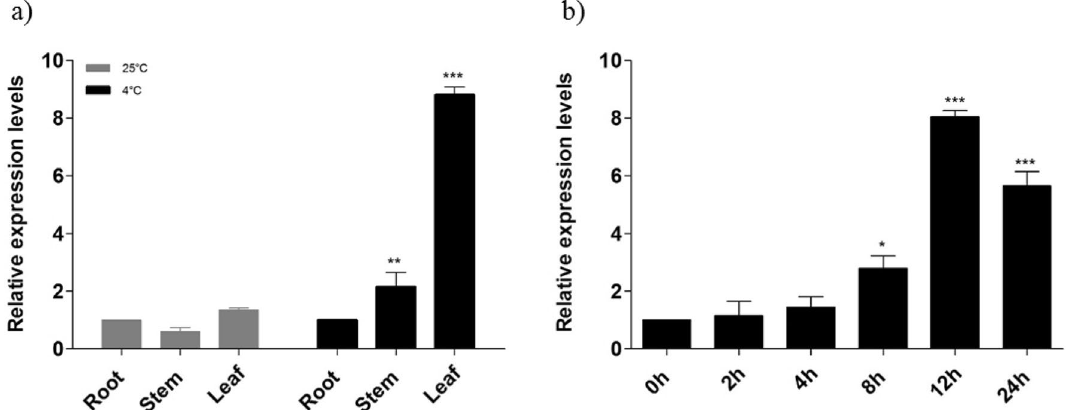
Figure 2. Expression pattern BoCRP1 in Brassica oleracea ( a ) Tissue specific expression of BoCRP1 in root, stem and leaf under both normal (25 °C) and cold (4 °C) after 12 h. ( b ) qPCR data showing time course expression of BoCRP1 under cold stress conditions (4 °C) for 24 h in Brassica oleracea . The bars indicates standard deviation (SD) and Asterisks represents significant differences between wild-type and transgenic lines. * P < 0.05; ** P < 0.01; *** P < 0.001 Tukey’s Multiple Comparison Test.